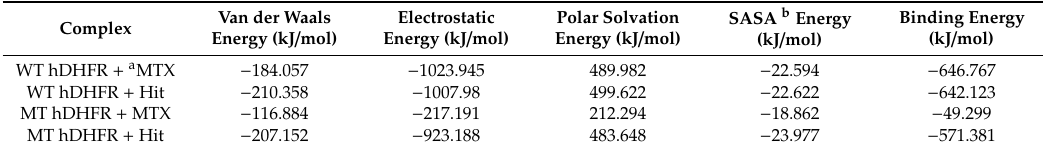
Figure 7. Binding free energy analyses. ( A ) Graphical representation of MM/PBSA estimated binding free energy of wild type and mutant hDHFR in complex with MTX (reference) and Hit compound throughout the simulation time. The reference compound is depicted as light blue and dark blue for wild type and mutant hDHFR, respectively. The Hit compound is shown in pink and magenta colors for wild type and mutant hDHFR, respectively. ( B ) The binding free energy decomposition analysis of the final hits in the active site of hDHFR infers that the Hit compound was comparably strongly bound with WT and MT hDHFR, while MTX lost its binding with the mutant structure. Table 6. Decomposition of binding free energy.